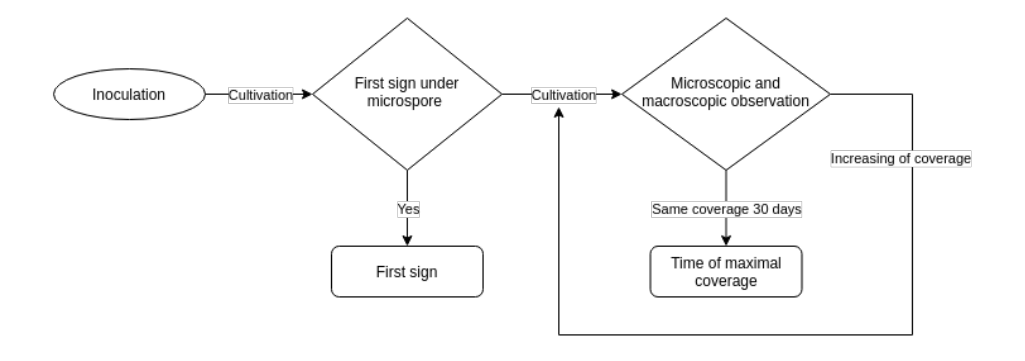
Figure 2. First sign of mold growth and maximal